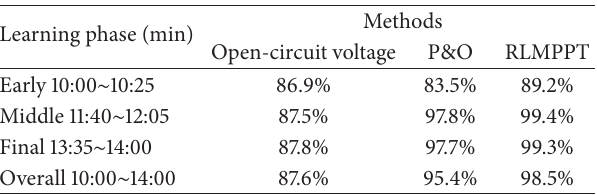
Table 4: Comparison of efficiency factor for the three comparing